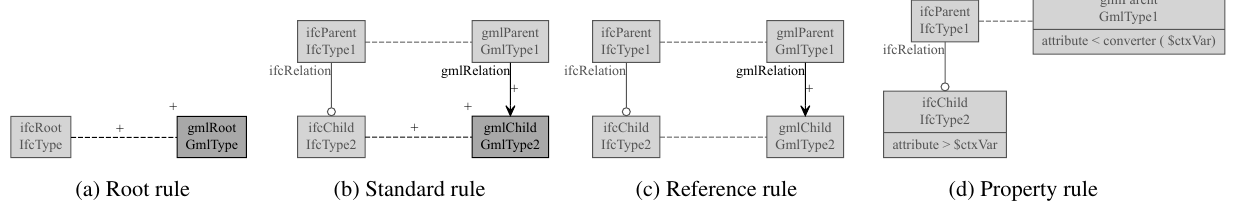
Figure 5. Rule types as deduced from the requirements of the conversion procedure